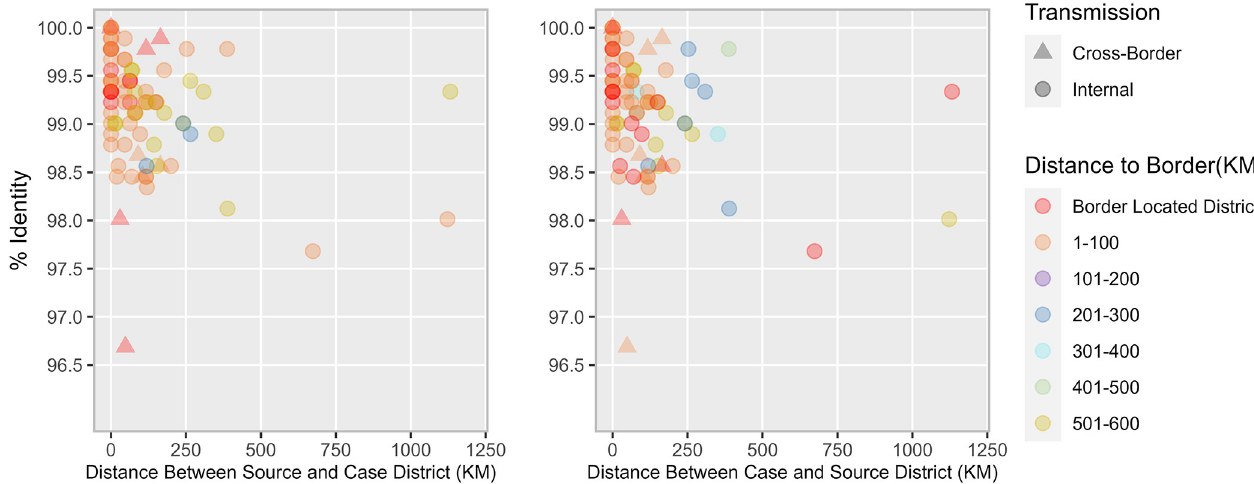
Fig 3. Scatterplot depicting A. nucleotide sequence identity (y-axis) for source districts in relation to the distance from its case district (x-axis) and distance from the border (color-coded) and B. nucleotide sequence identity (y-axis) for case districts in relation to the distance from its source district (x-axis) and distance from the border (color-coded) categorized under cluster